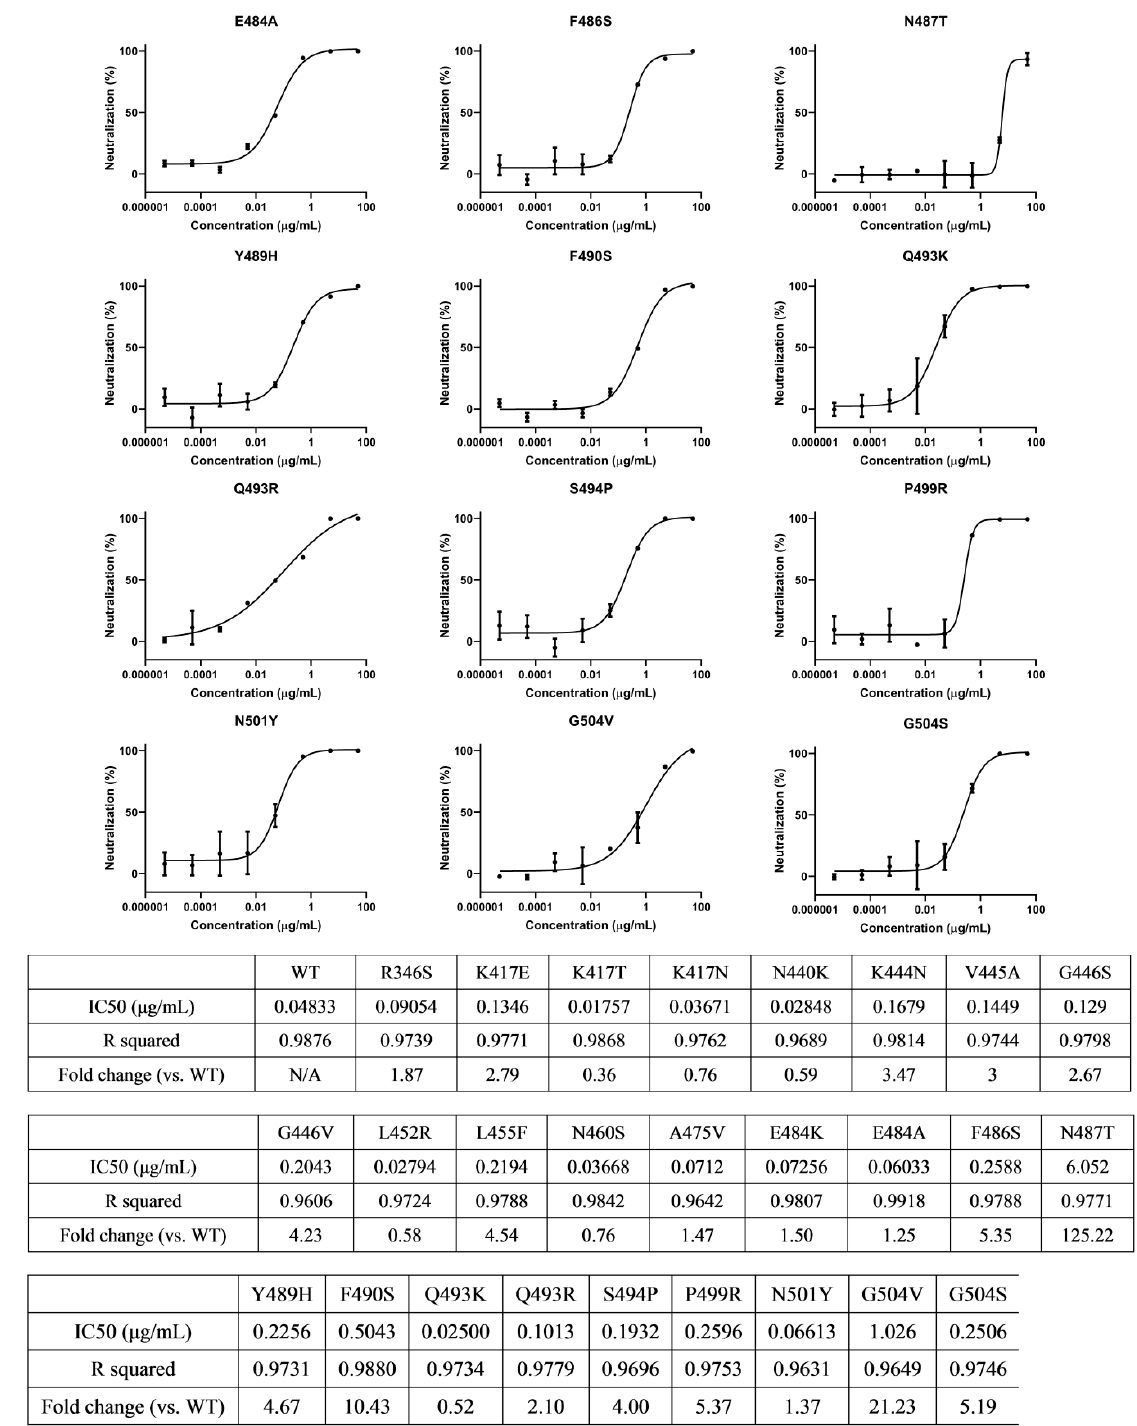
Figure 2. ACE2-Fc efficiently neutralized various single-residue mutated variants. The variants in these tables were found to escape antibody therapeutics either Emergency Use Authorization (EUA) authorized or in clinical trials, according to references listed in Figure S2. Neutralization ratios were calculated as described in Figure 1 (mean ± SD, n = 2). IC 50 values were calculated using four-parameter nonlinear regression fitting.